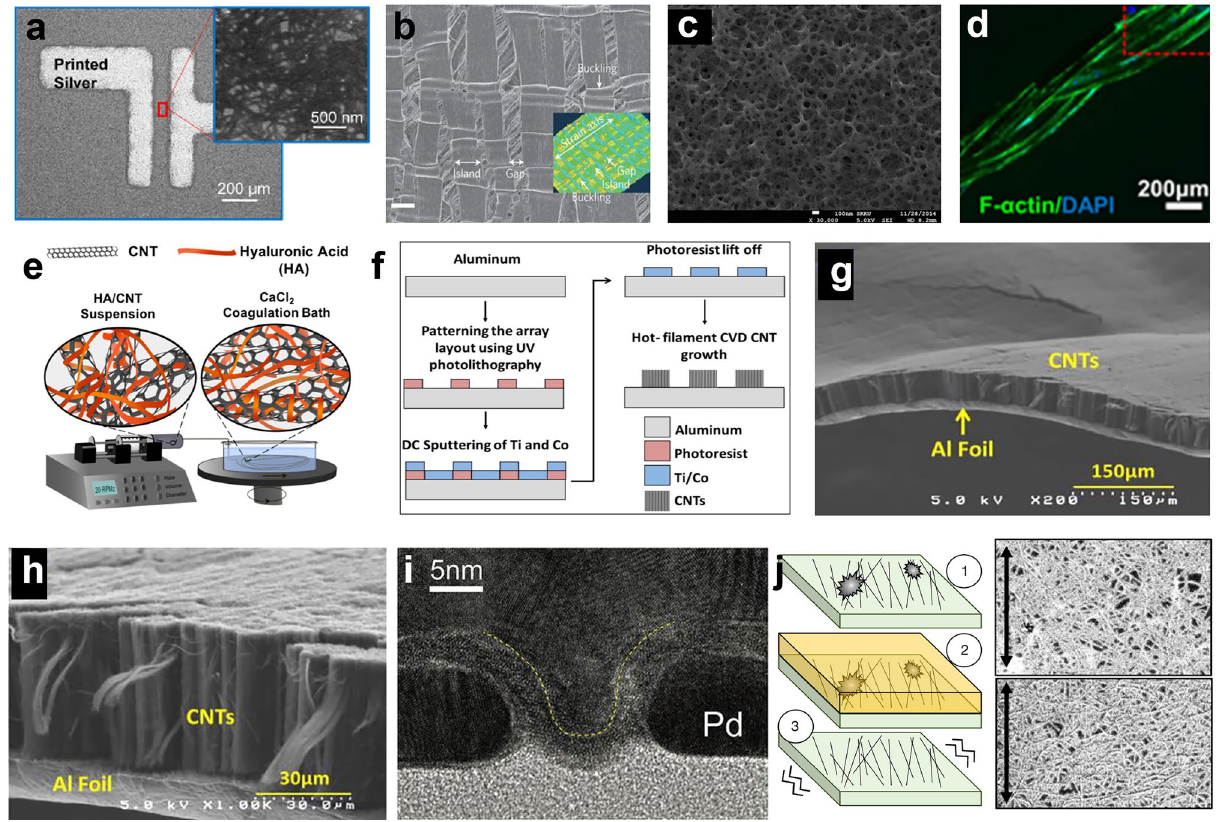
Fig. 2 Microstructure and fabrication process of CNTs-based devices. a SEM image shows the SWCNT network between the printed Ag elec- trodes. The inset shows the incubated SWCNT network on the PET substrate as the channel region. Reproduced with permission [42]. Copy- right (2016), American Chemical Society. b SEM image of the fractural structure of the SWCNT film grown from patterned catalysts using water-assisted CVD. Scale bar represents 5 µm. Inset: 3D image at 100% strain. Reproduced with permission [44]. Copyright (2011), Nature Publishing Group. c Top-view FE-SEM image of the PU-Poly(3,4-ethylenedioxythiophene)/Poly(styrenesulfonate) (PEDOT:PSS)-PDMS hybrid structure with SWCNT solution drop coated on it. Reproduced with permission [45]. Copyright (2015), American Chemical Society. d Implant- able CNTs-based hybrid microfiber with tissues on it and e Schematic illustration of the wet-spinning setup for the fabrication of SWCNT hybrid microfibers with SWCNT concentration of 4 mg mL −1 . Reproduced with permission [47]. Copyright (2019), American Chemical Society. f Fab- rication process of the 3D patterned CNT array on aluminum substrate, and SEM micrographs of the vertically aligned CNTs on the aluminum substrate at different magnifications: g 200 × ; h 1 k × . Reproduced with permission [52]. Copyright (2017), Elsevier. i TEM image of a normal Pd-contacted CNT FET with gate length of 5 nm, the CNT FET synthesized by CVD. Reproduced with permission [65]. Copyright (2017), American Association for the Advancement of Science. j Removal of the aggregates CNTs on the wafer and the SEM image of it (the top- view CNT incubation pre-removed, and the bottom shows CNTs left on the wafer post-removed). Reproduced with permission [66]. Copyright (2019), Nature Publishing